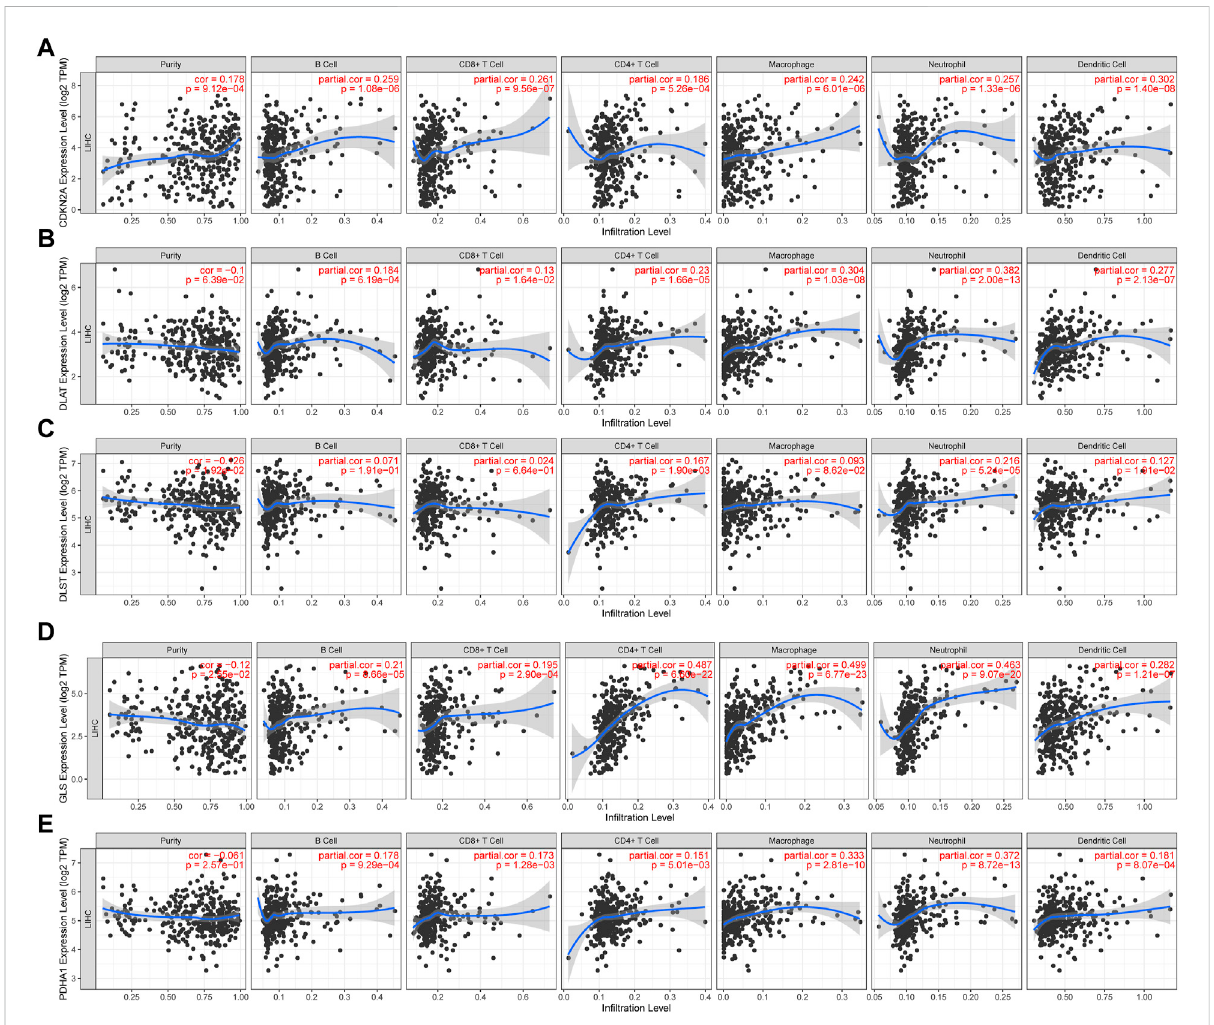
FIGURE 7 The correlation between fi ve prognostic CRGs and immune in fi ltration. The association between the abundance of immune cells and the expression of CDKN2A (A) , DLAT (B) , DLST (C) , GLS (D) , and PDHA1 (E) in HCC.